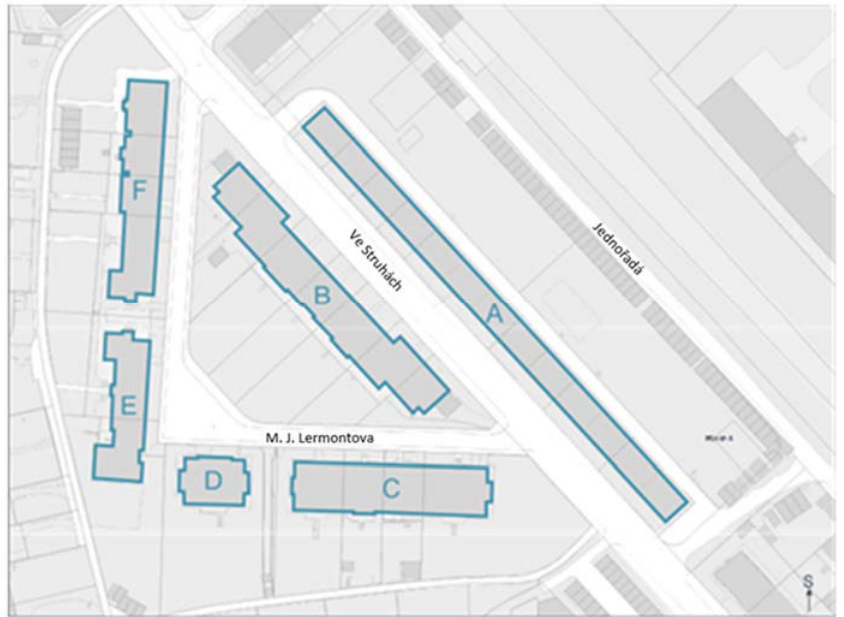
Figure 3. Delimitation of residential zones in the area of the experiment (around the streets of M. J. Lermontova and Ve Struhách, Prague ‐ Bubenec).